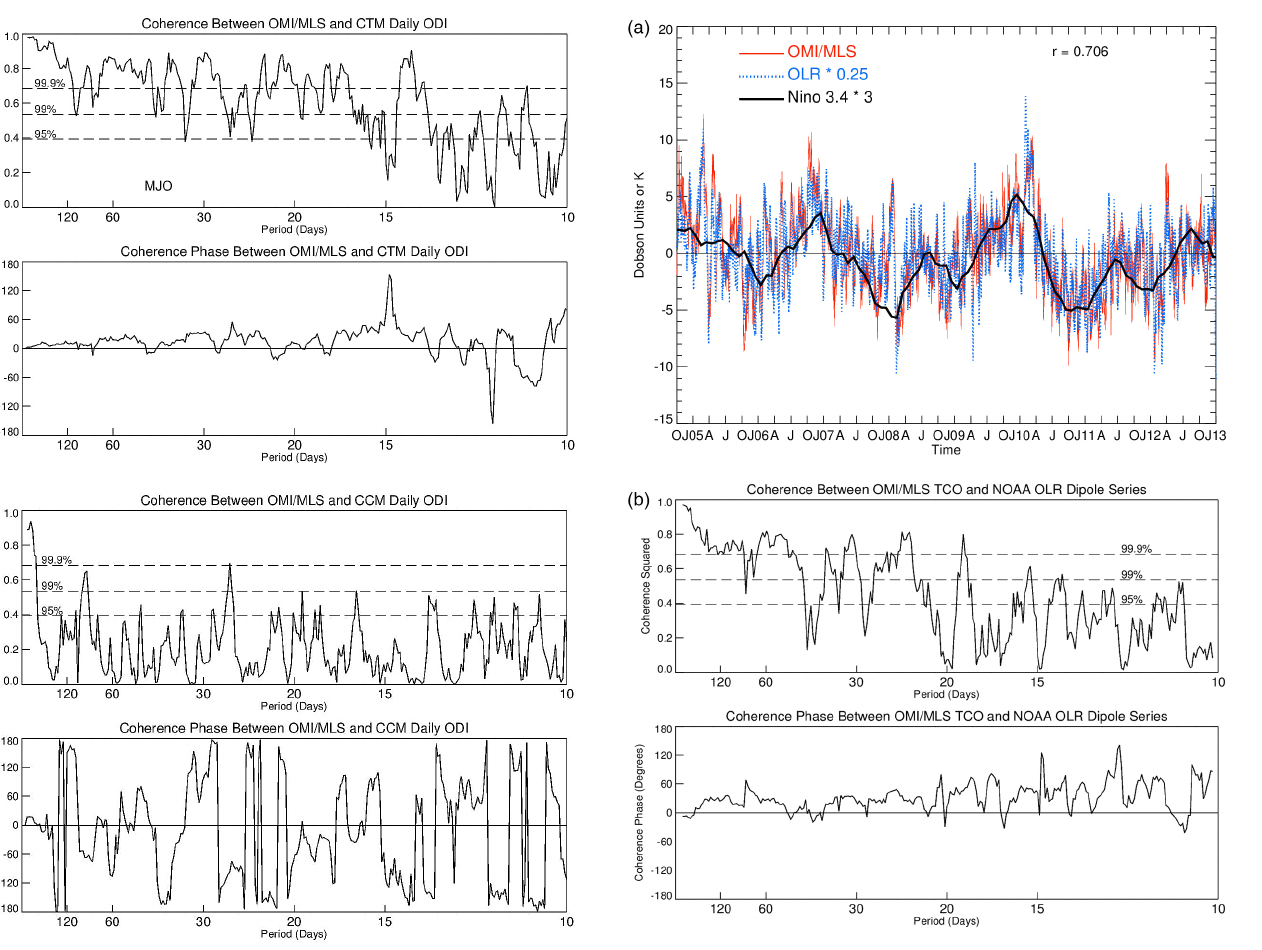
Figure 3. This figure plots calculated coherence and phase of co- herence between OMI/MLS ODI and model (i.e., CTM and CCM) ODI as functions of frequency (periods in days shown). (a) Top panel: coherence-squared between OMI/MLS ODI and CTM ODI. Included are confidence levels for coherence-squared of 95% (i.e., value of 0.393), 99% (value of 0.536), and 99.9% (value of 0.684). Bottom panel: phase of coherence in degrees. Panel (b) is the same as (a) but for the CCM instead of CTM (see Appendix A for details of these calculations).